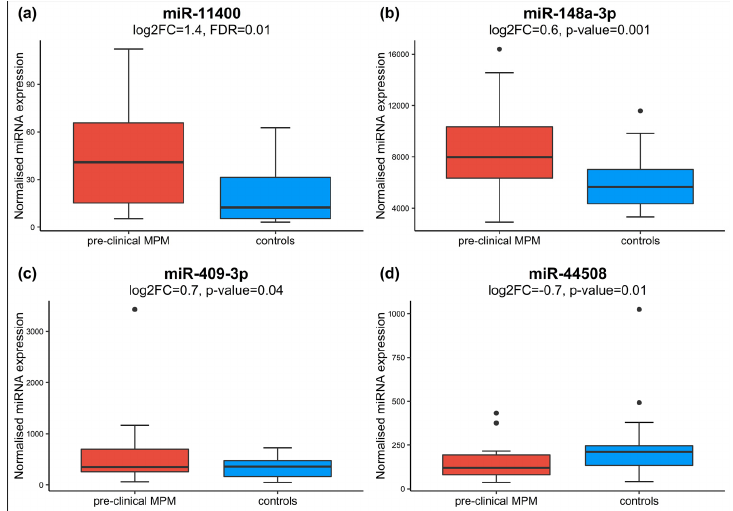
Figure 2. Boxplots show expression levels of miR-11400 ( a ), miR-148a-3p ( b ), miR-409-3p ( c ), and miR-4508 ( d ), in pre-clinical MPM cases collected up to five years before diagnosis and matched controls. Above each boxplot, the p -values yielded by DESeq2 after adjustment for multiple testing (FDR) or nominal p -value.